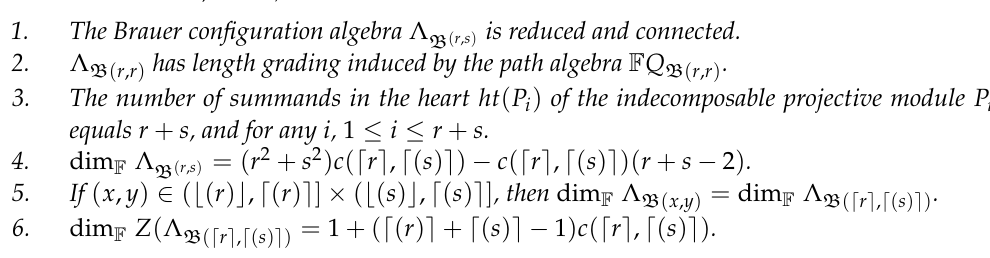
( c y ) associated with the vertex x ( y ), 1 j , m i , k